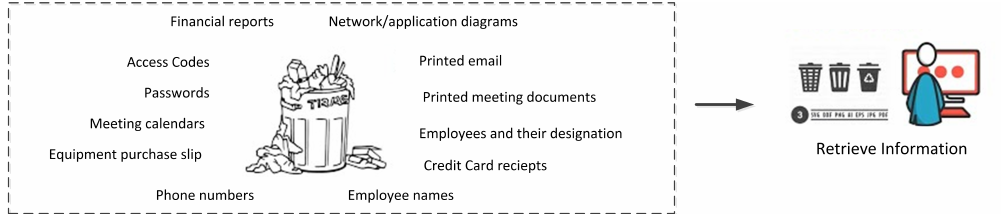
Figure 3. Content that can be found via dumpster-diving in an organization’s